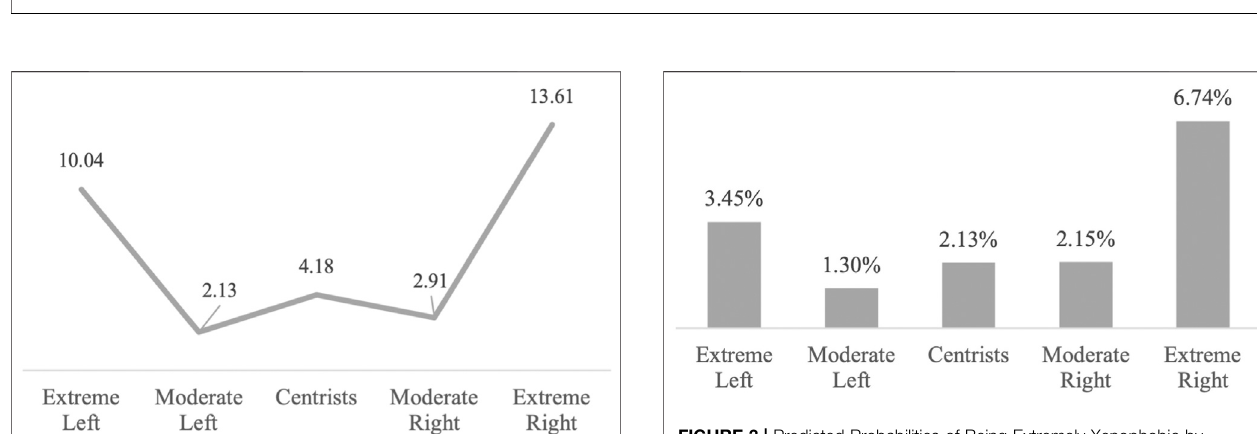
FIGURE 1 | Relationship between Political Ideology and Attitudes Towards Immigrants. Source: European Social Survey, cumulative dataset, waves 1 – 9. Own calculations.